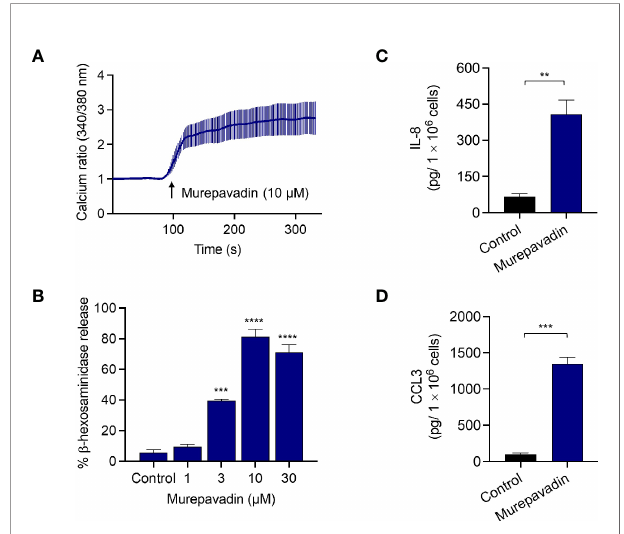
FIGURE 1 | Murepavadin induces intracellular Ca 2+ mobilization, degranulation and causes chemokine production in human MCs. (A) Ca 2+ mobilization measurement following murepavadin (10 m M) stimulation of Fura-2-loaded LAD2 cells. (B) LAD2 cells were exposed to indicated concentrations of murepavadin (30 min) and degranulation was assayed by measuring the release of b -hexosaminidase. (C, D) LAD2 cells were exposed to 10 m M of murepavadin for 24 h and the production of IL-8 and CCL3 were determined by ELISA. Data presented are the mean ± SEM of at least three experiments. Statistical signi fi cance was determined by t -test or one-way ANOVA with Dunnett ’ s multiple comparisons at a value ** p < 0.01, *** p < 0.001, and **** p <